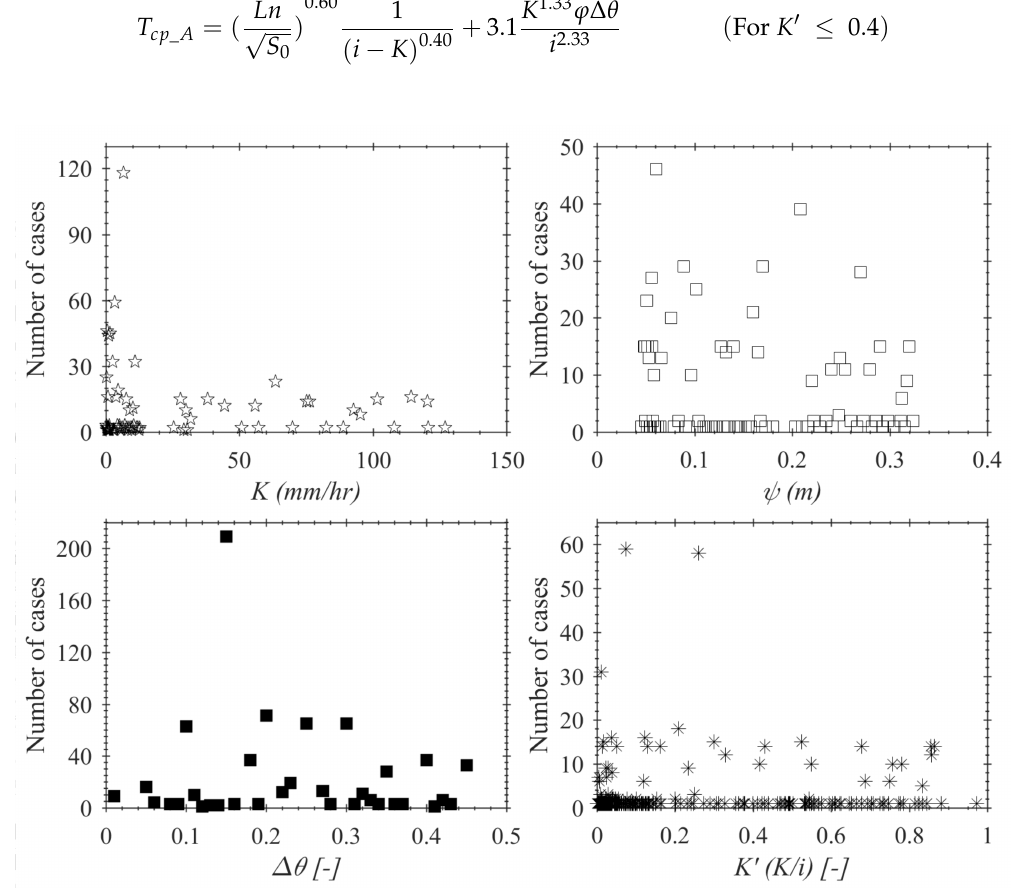
Figure 2. Distributions of the values of three soil infiltration parameters and calculated K (cid:48) = K/i used for 750 pervious modeling